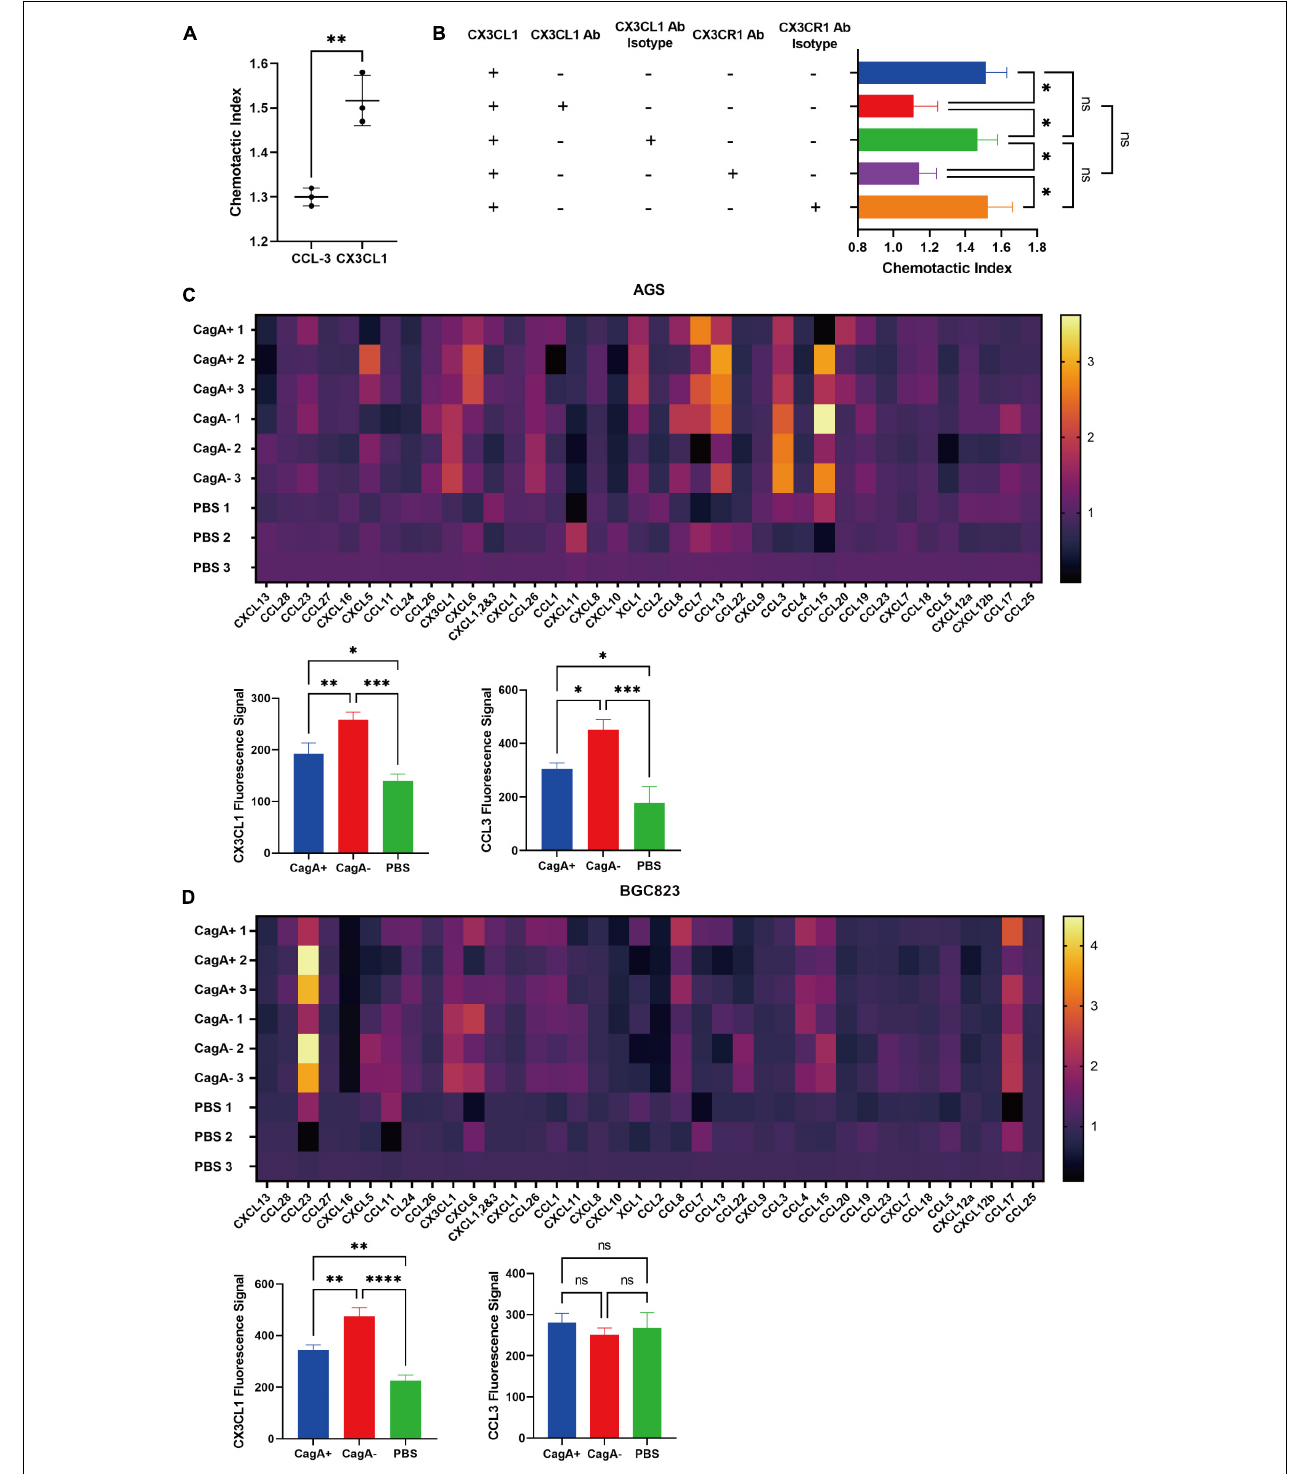
FIGURE 3 | Chemotaxis assay and chemokines secreted by gastric epithelial cell lines. (A) Transwell migration assay. Purified splenic CD4 + T cells from WT mice were added to the upper chambers of a transwell plate. The lower chambers were filled with the complete RPMI-1640 medium containing 500 ng/ml of mouse chemokine CCL-3, CX3CL1, or PBS as the control. Data are shown as the chemotactic index (number of cells that migrated to the medium containing chemokine divided by the number of cells that migrated to the medium containing PBS). (B) Gastric CD4 + T cells were isolated from stomachs of CagA − H. pylori-